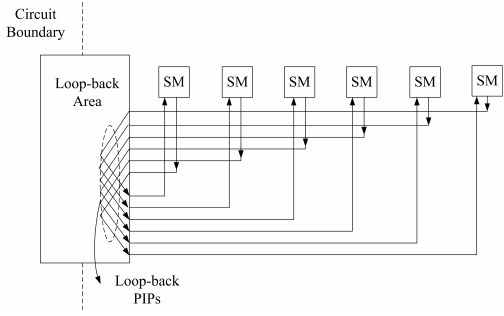
Figure 6. Loop-back PIPs in